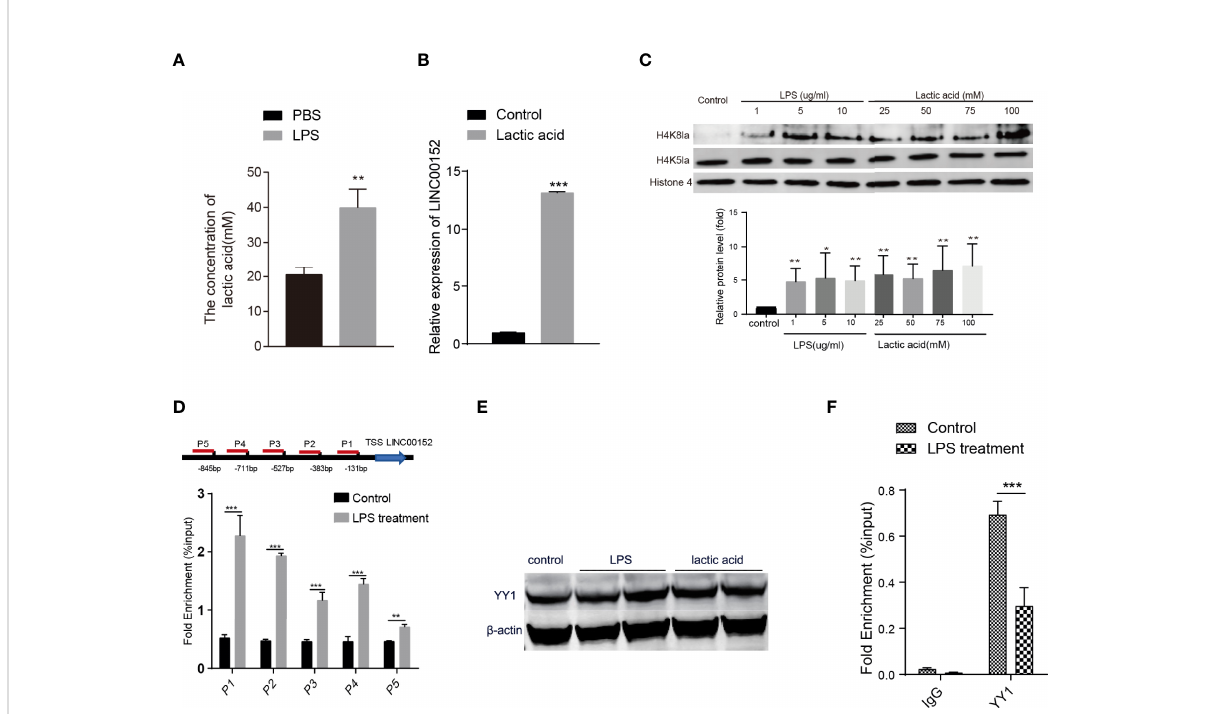
FIGURE 4 The epigenetic modi fi cations of bacteria-introduced lncRNA. (A) LPS induced an elevated level of lactic acid in HCT116 cells. (B) The expression of LINC00152 level in the lactic acid-treated cells (N=3). (C) The level of histone lysine lactylation in the LPS treated cells (N=3). (D) ChIP-qPCR revealed that the binding signaling of H4K8la to the LINC00152 promoter regions was higher than in the LPS treated cells compared with control group (N=3). (E) The expression of YY1 upon LPS and lactic acid treatment (N=2). (F) LPS reduced the binding ef fi ciency of YY1 to the LINC00152 promoter compared with the control group (N=3). * P < 0.05; ** P < 0.01 *** P <